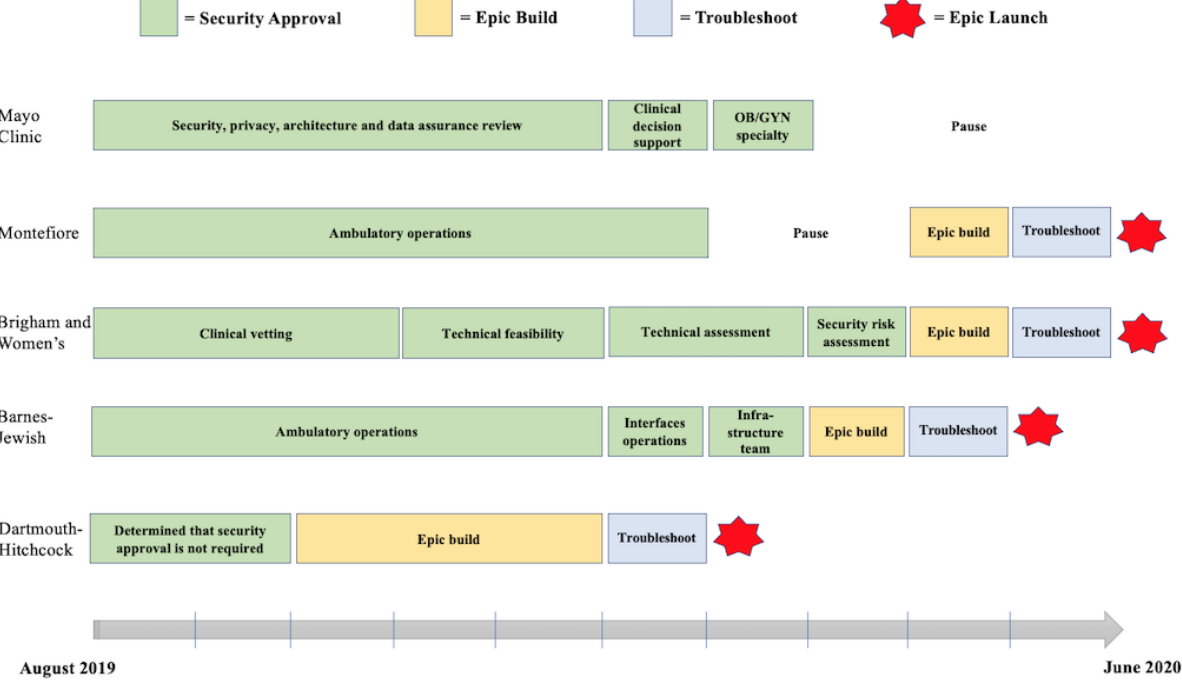
Aim 2: Thematic Analysis of Facilitators and Barriers to EHR